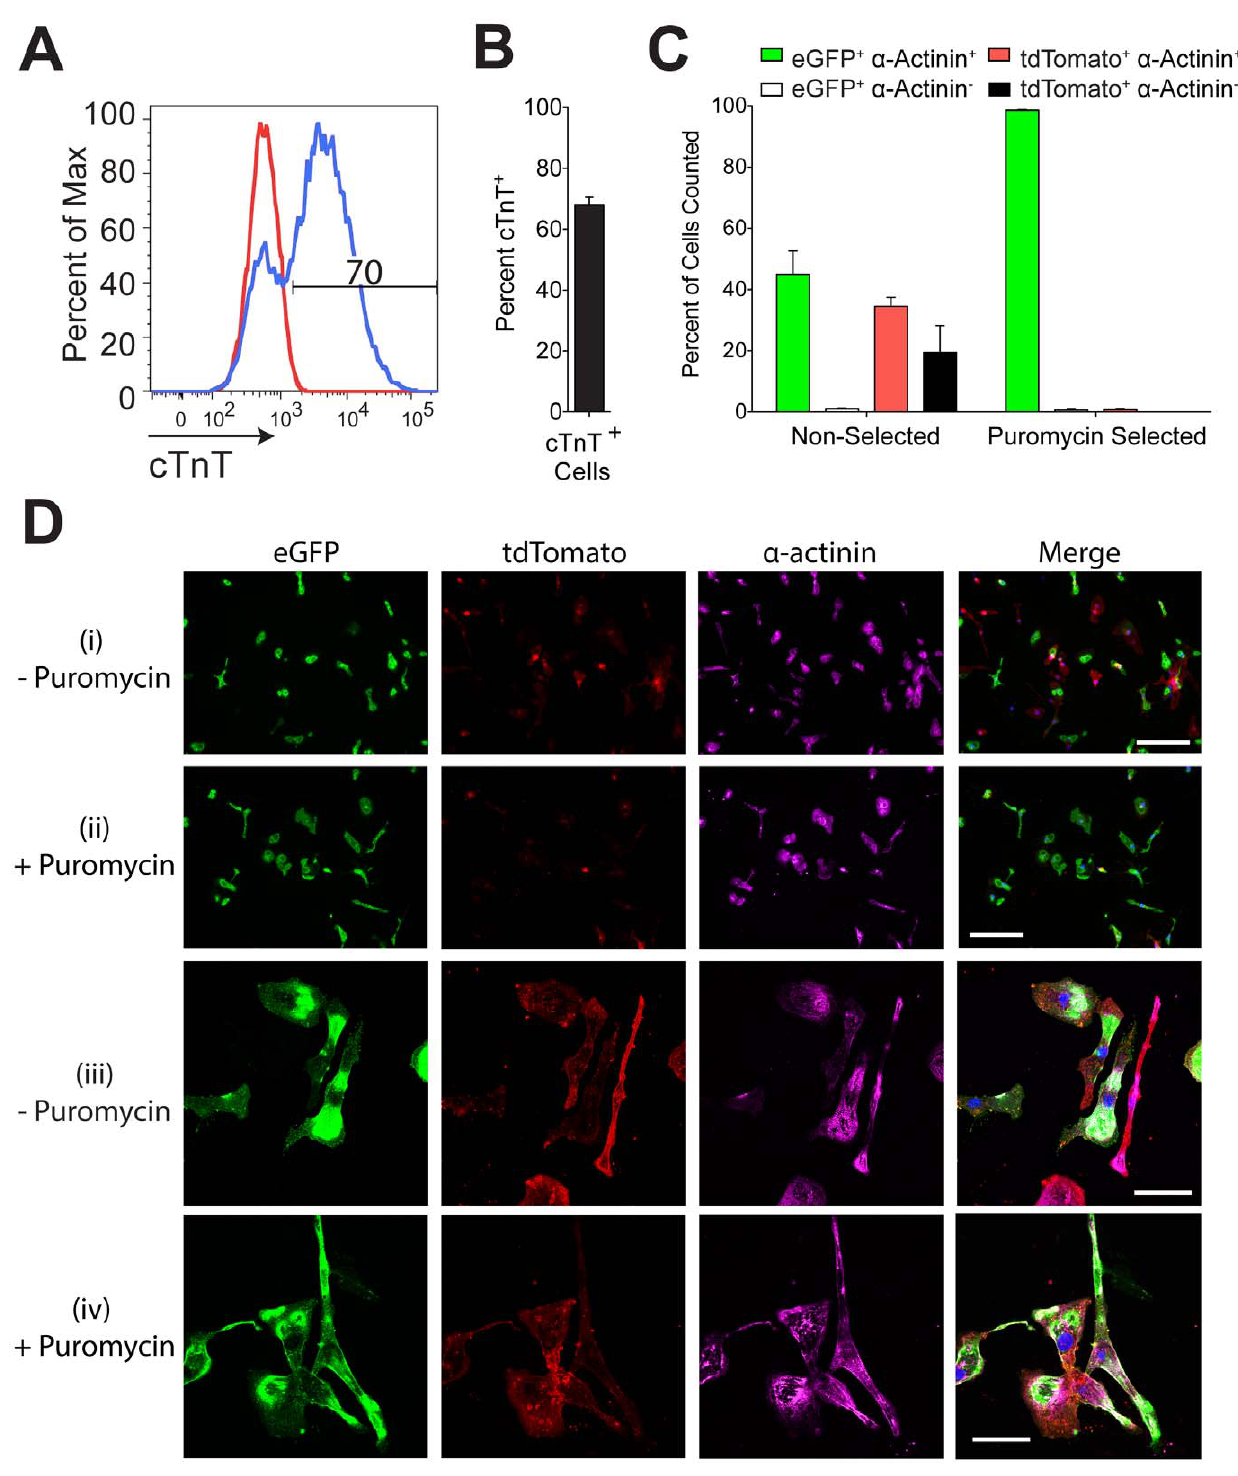
Figure 4. Using CK-7 Cre in combination with mTmG-2a-Puro cells enables cardiomyocyte purification. ( A ) Flow cytometry for cardiac troponin T (cTnT) indicating the percentage of cardiomyocytes present after mTmG-2a-Puro hESCs were subjected to a directed cardiac differentiation protocol. ( B ) Mean percentage of cTnT + cells resulting from three independent differentiation runs. ( C ) The percentage of cells that immunostained for eGFP, tdTomato, and/or the cardiomyocyte marker a -actinin was determined before and after puromycin selection (n=230–600 cells per condition for three independent differentiation runs). ( D ) Magnification at 10x (i and ii) and 60x (iii and iv) showing fluorescent photomicrographs of cardiac differentiated mTmG-2a-Puro cells before (i and iii) and after (ii and iv) puromycin selection. Scale bars are 200 m m in (i and ii) and 50 m m in (iii and iv). Error bars represent one standard error of the mean.